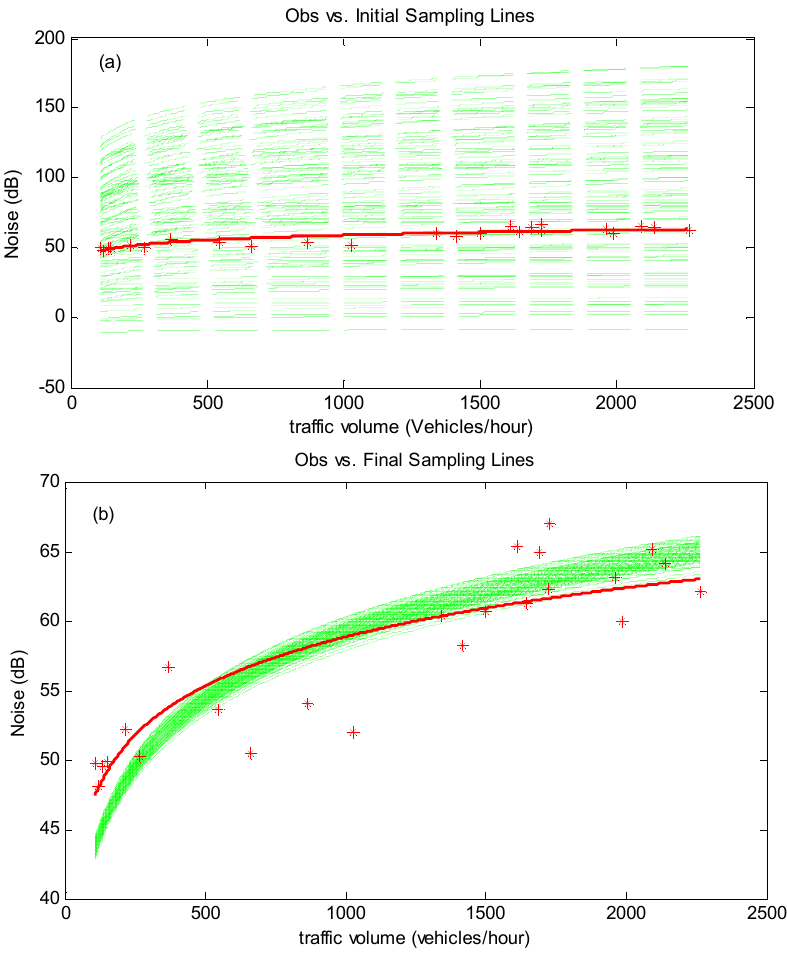
Figure 7. Initial ( a ) and updated ( b ) traffic noise prediction curves in scenario A 2.